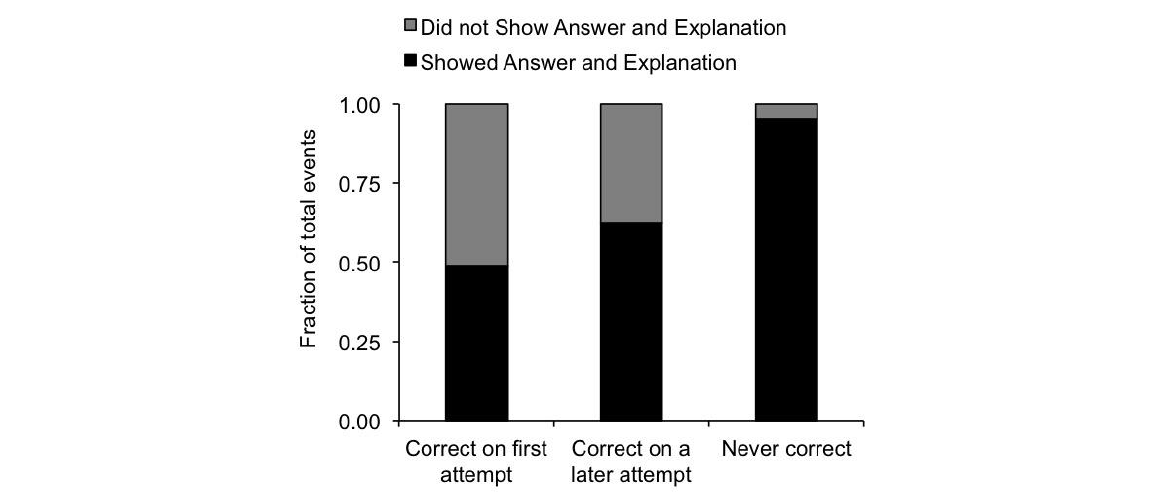
Figure 3. Students opt in to reading explanations in online